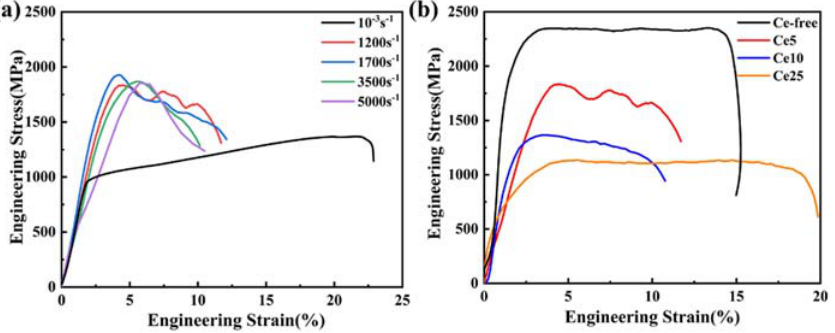
Figure 5. Mechanical behavior of CeX: ( a ) Compressive-engineering-stress-versus-engineering-strain curves of Ce5 at different strain rates and ( b ) compressive-engineering-stress-versus-engineering-strain curves of CeX at 1200 s − 1 .